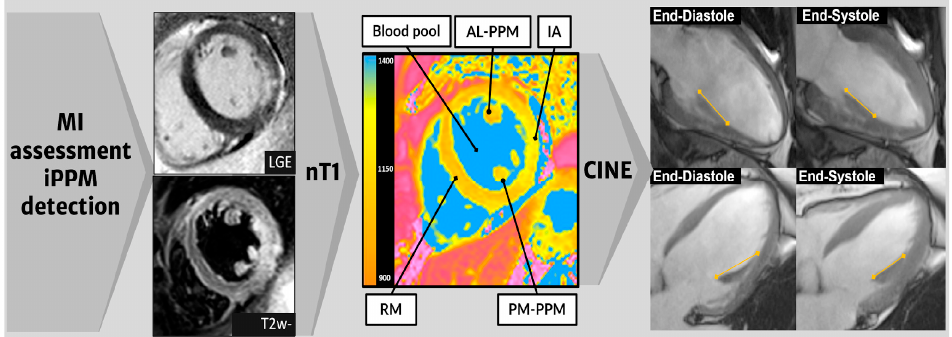
Figure 1. Scheme of CMR image analysis process. LGE and T2-STIR images were analyzed to identify IA, RM, BP, and the two PPMs. Then, nT1 was measured by placing multiple ROIs in the previously defined areas. Finally, the cineMR images acquired on long axis views (two chambers, in the upper row, and four chambers below) in the end-diastolic and end-systolic phases were evaluated to calculate the PPM-ls. CMR: cardiac magnetic resonance; LGE: late gadolinium enhancement; STIR: short tau inversion recovery; BP: blood pool; RM: remote myocardium; IA; infarcted area; AL: anterolateral; PM: posteromedial; PPM-ls: PPM longitudinal strain; ROI: region of interest. The presence of MVR was detected in echocardiographic exams and during the CMR exam and classified as no-regurgitation, mild, moderate, and severe. All patients were classified into two groups (iPPM and niPPM) based on the presence or absence of iPPM, respectively.